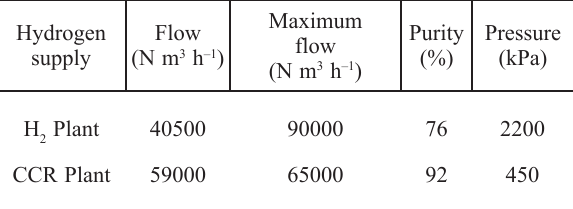
Table 3 – Hydrogen sinks data for case study